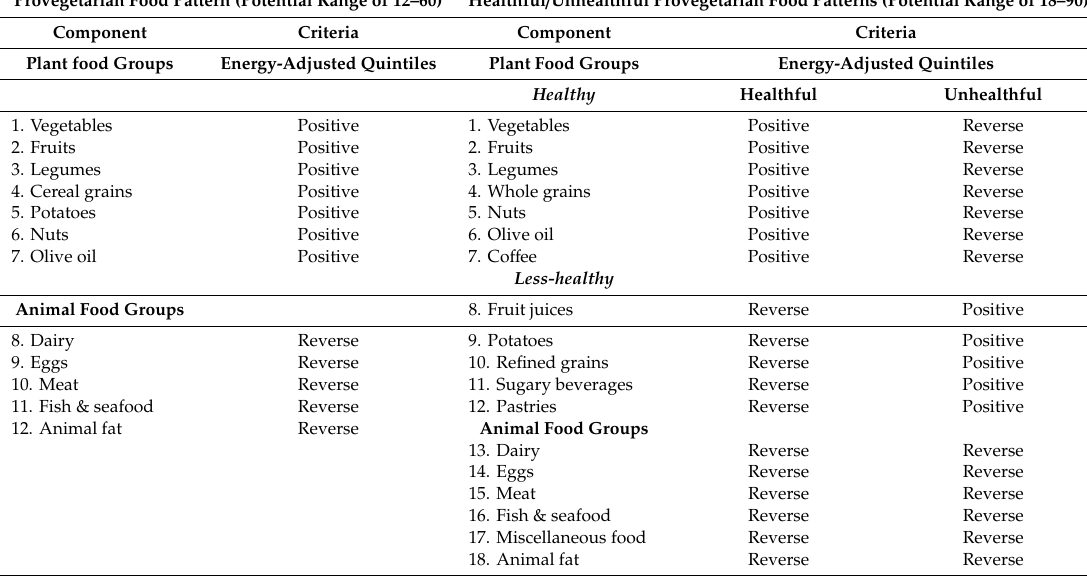
Table 1. Scoring criteria for the provegetarian food